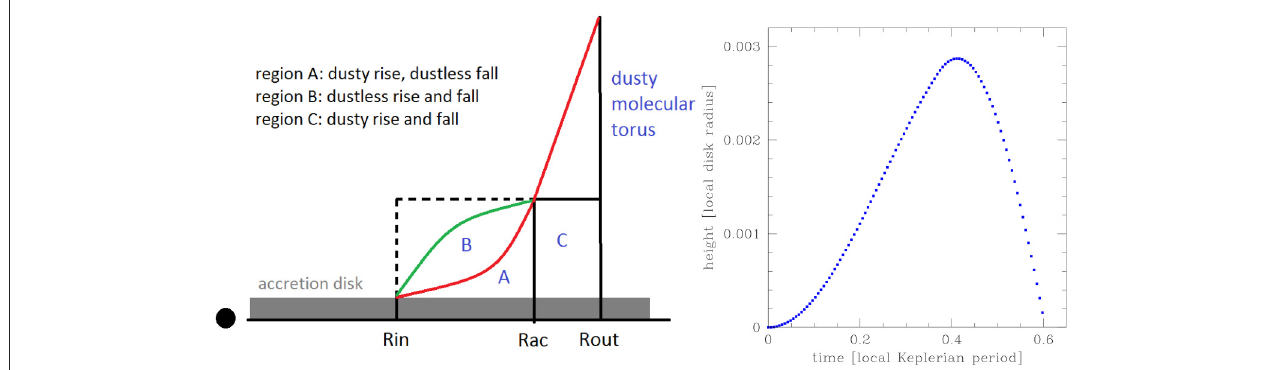
FIGURE 2 | Schematic drawing of the BLR region (left) and an example of a single cloud motion in the A/B region showing clear asymmetry in the rise and fall motion due to the dust evaporation (right) .